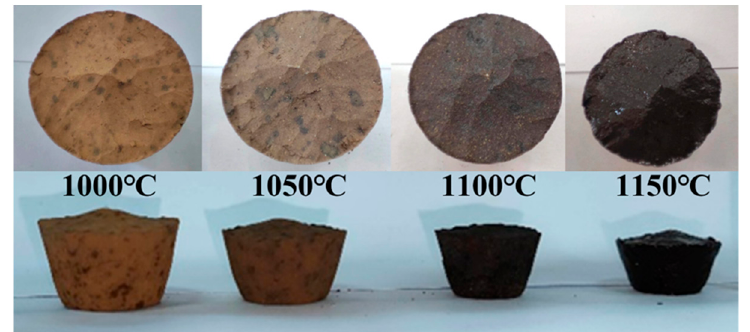
Figure 4. The macroscopic pictures of the sintering samples sintered at 1000–1150 °C (the Ca/(Si + Ti) ratio is 1.8 and MgO mass percentage in spinel is 14.89%).